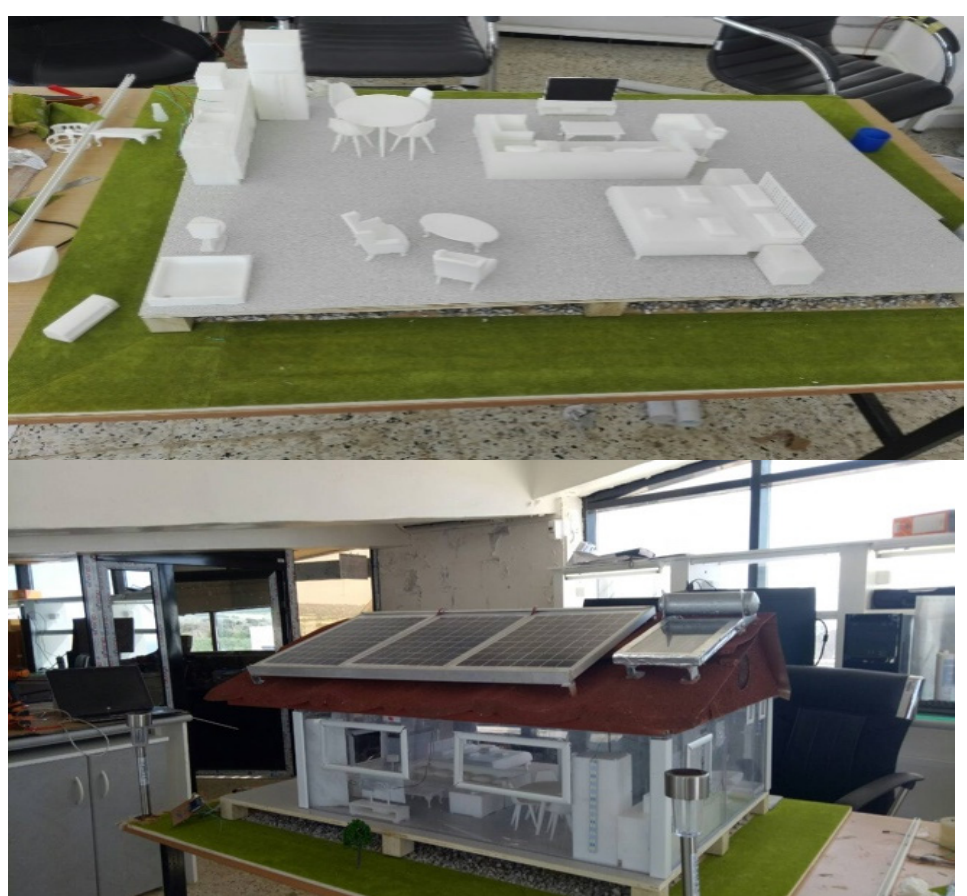
Figure 9. Realization of the model of the solar house.